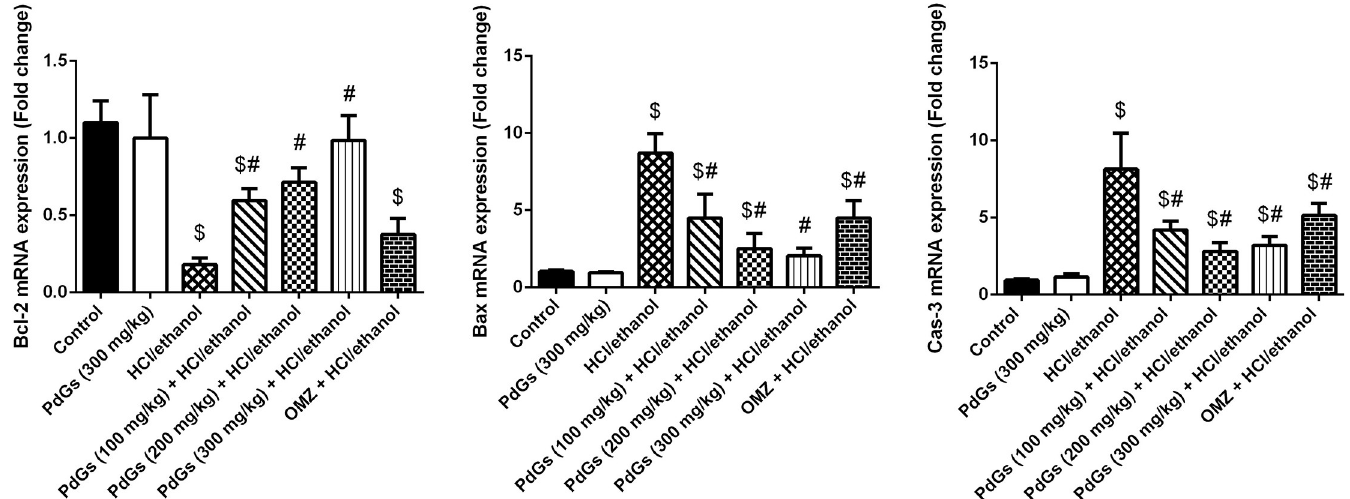
Fig 10. Effect of prodigiosins on the mRNA expression of Bax , Bcl2 , and Casp3 in gastric tissue. Data (means ± SEM of three assays) were normalized to the mRNA levels of Gapdh and expressed as fold induction (log2 scale), relative to the mRNA level of Bax , Bcl2 , and Casp3 in the health. a P < 0.05, significant difference vs . the health rats; b P < 0.05, significant difference vs . HCl/ethanol-induced rats, Duncan’s post-hoc test.